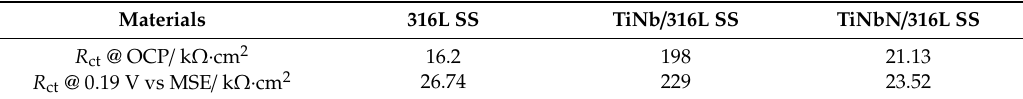
Figure 8. Equivalent circuits used for the Nyquist impedance spectra of ( a ) TiNbN / 316L SS @ OCP; ( b ) TiNbN / 316L SS @ 0.19 V vs MSE, 316L SS, and TiNb / 316L SS. Table 1. R ct values of 316L SS, TiNb / 316L SS and TiNbN / 316L SS at di ff erent